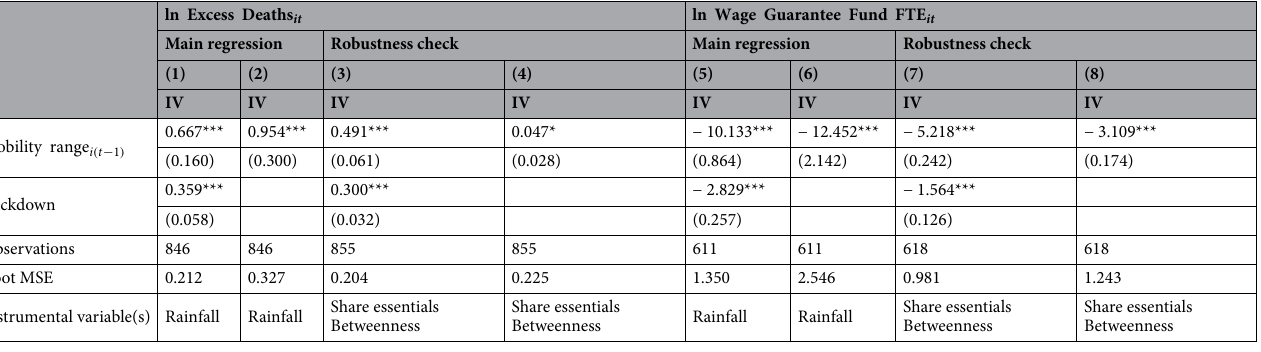
Table 1. Instrumental variable regression results for excess deaths and WGF. Columns from (1) to (4) and from (5) to (8) display IV regression estimates for the logarithm of excess deaths and the Wage Guarantee Fund, respectively. Robust standard errors are reported in parentheses. All models control for NUTS 3 region- specific fixed effects. Specifications in columns (1), (3), (5) and (7) control for time trends with the Lockdown dummy, which takes value 1 when the first countrywide lockdown was in force (March, April, May). Estimates in columns (1)–(2) and (5)–(6) are obtained instrumenting for mobility range by the share of consecutive rainy days recorded in a month. As a robustness check, model specifications in columns (3)–(4) and (7)–(8) employ both the time-varying share of essential residents and NUTS 3 regions’ betweenness centrality as excluded instruments for mobility range. All IVs have been lagged by one month to be in line with the endogenous regressor. First stage and reduced form results are reported in SI (see S3). For comparative purposes, section S3 in SI Appendix displays fixed-effects estimates obtained without employing any instrumental variable, still controlling for NUTS 3 region-specific and time-specific fixed effects. * p < 0.10 , ** p < 0.05, *** p <